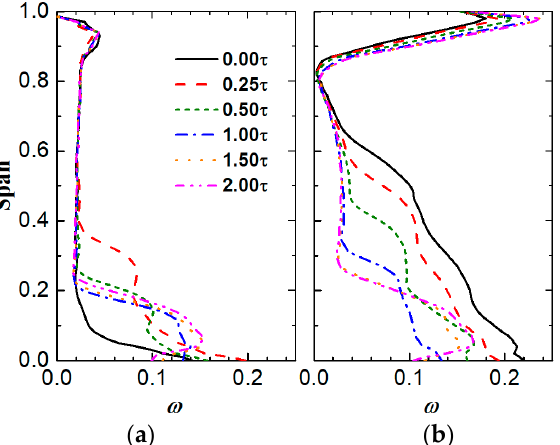
Figure 14. Circumferentially averaged total pressure loss coefficient of the stator. ( a ) In the DE condition; ( b ) in the NS condition.